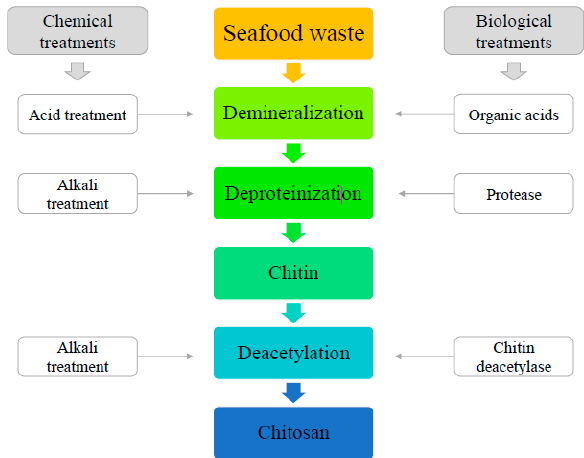
Figure 5. Chitin and chitosan production by chemical and biological treatments.